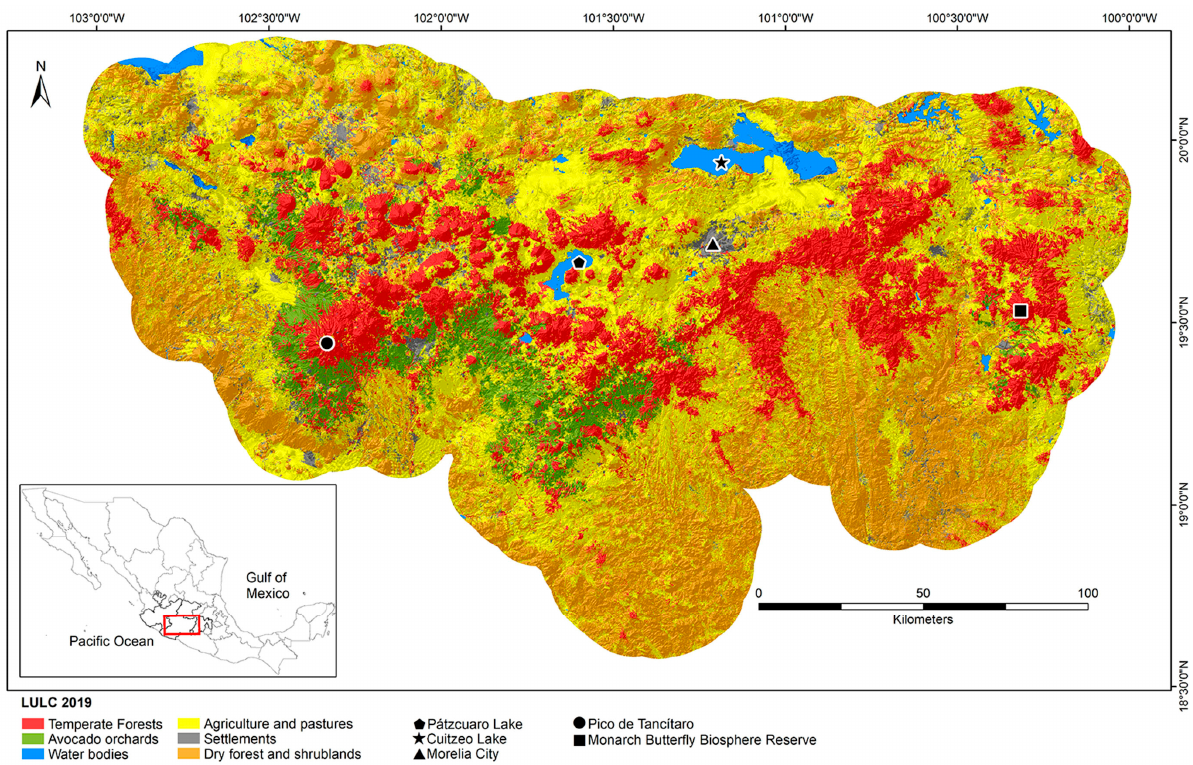
Figure 1. Land-use and land-cover map (2019) of the Avocado Belt, located in the state of Michoacán, Mexico. The inset on the bottom left shows the geographic location of the study area (red box) within the country.